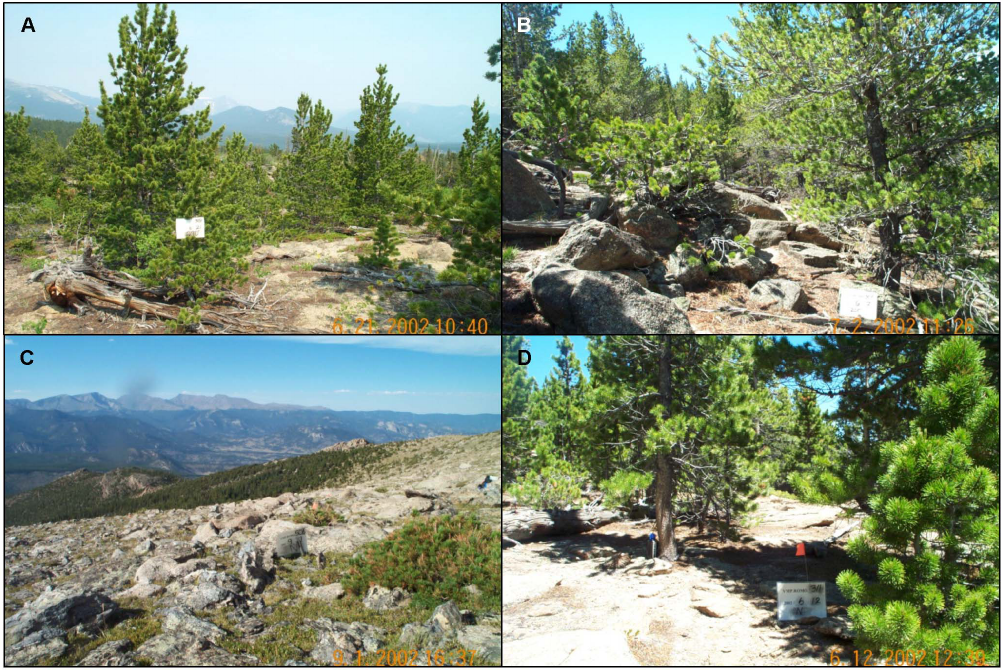
Figure 3. Examples of field plots containing limber pine in Rocky Mountain National Park, according to photos collected as part of the vegetation inventory [ 33 ] . A) Plot number 318, representative of the subalpine (dominant) limber pine map class. B) Plot number 303, representative of the subalpine (dominant) limber pine map class. C) Plot number 506, representative of the herbaceous upland alpine fellfield map class. D) Plot number 311, representative of the lodgepole pine – low elevation , 9500 ft map class.